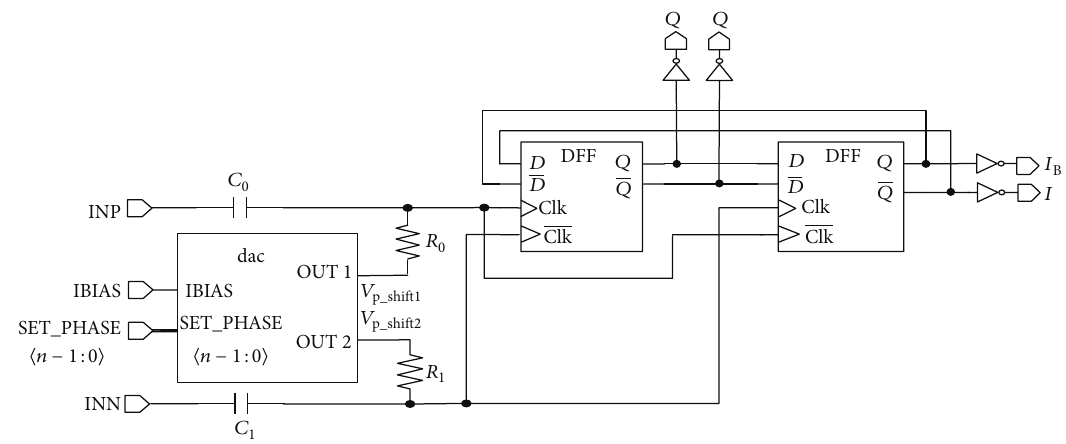
Figure 1: Circuit structure of the quadrature signal generator.